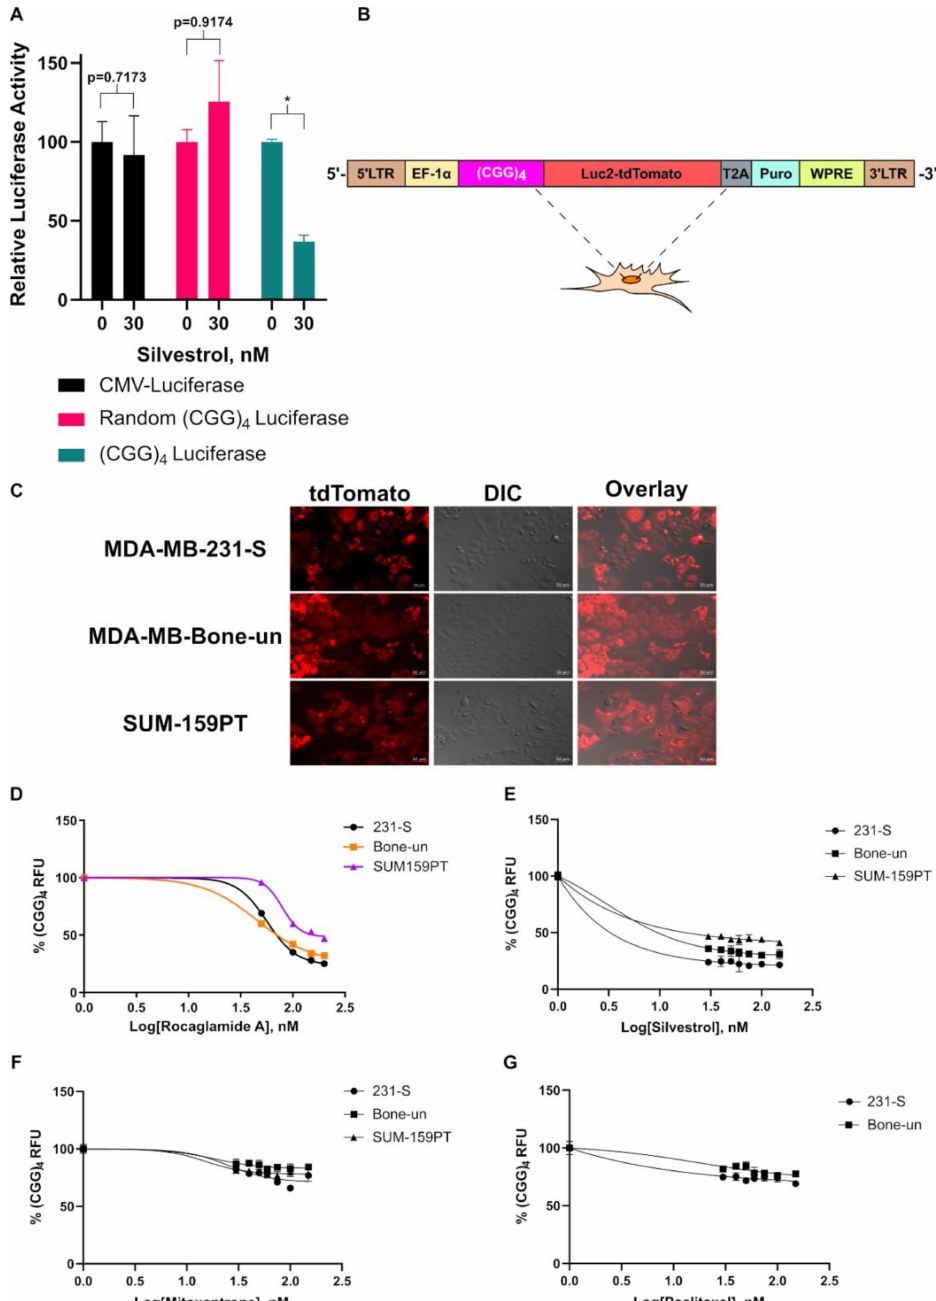
Figure 1. Characterization of the (CGG) 4 Luc2-tdTomato Reporter System. ( A ). (CGG) 4 luciferase assay in 293 cells following treatment with 30 nM silvestrol ( n = 3). Relative luciferase activity indicates the luminescent ratio of luciferase / renilla with untreated cells set to 100% (* indicates p < 0.05 as analyzed by a student’s t-test). ( B ). Cartoon representation of the (CGG) 4 Luc2-tdTomato reporter plasmid. ( C ). Live-cell fluorescent images of MDA-MB-231-S, MDA-MB-Bone-un, and SUM-159PT cells after introduction of the (CGG) 4 Luc2-tdTomato fusion protein ( n = 1). ( D ). (CGG) 4 Luc2-tdTomato readings in MDA-MD-231-S, MDA-MB-Bone-un, and SUM-159PT cells following treatment with 0–200 nM rocaglamide A ( n = 3). ( E ). (CGG) 4 Luc2-tdTomato readings in MDA-MD-231-S, MDA-MB-Bone-un, and SUM-159PT cells following treatment with 0–150 nM silvestrol ( n = 3). ( F ). (CGG) 4 Luc2-tdTomato readings in MDA-MD-231-S, MDA-MB-Bone-un, and SUM-159PT cells following treatment with 0–150 nM mitoxantrone ( n = 3). ( G ). (CGG) 4 Luc2-tdTomato readings in MDA-MD-231-S and MDA-MB-Bone-un cells following treatment with 0–150 nM paclitaxel ( n =